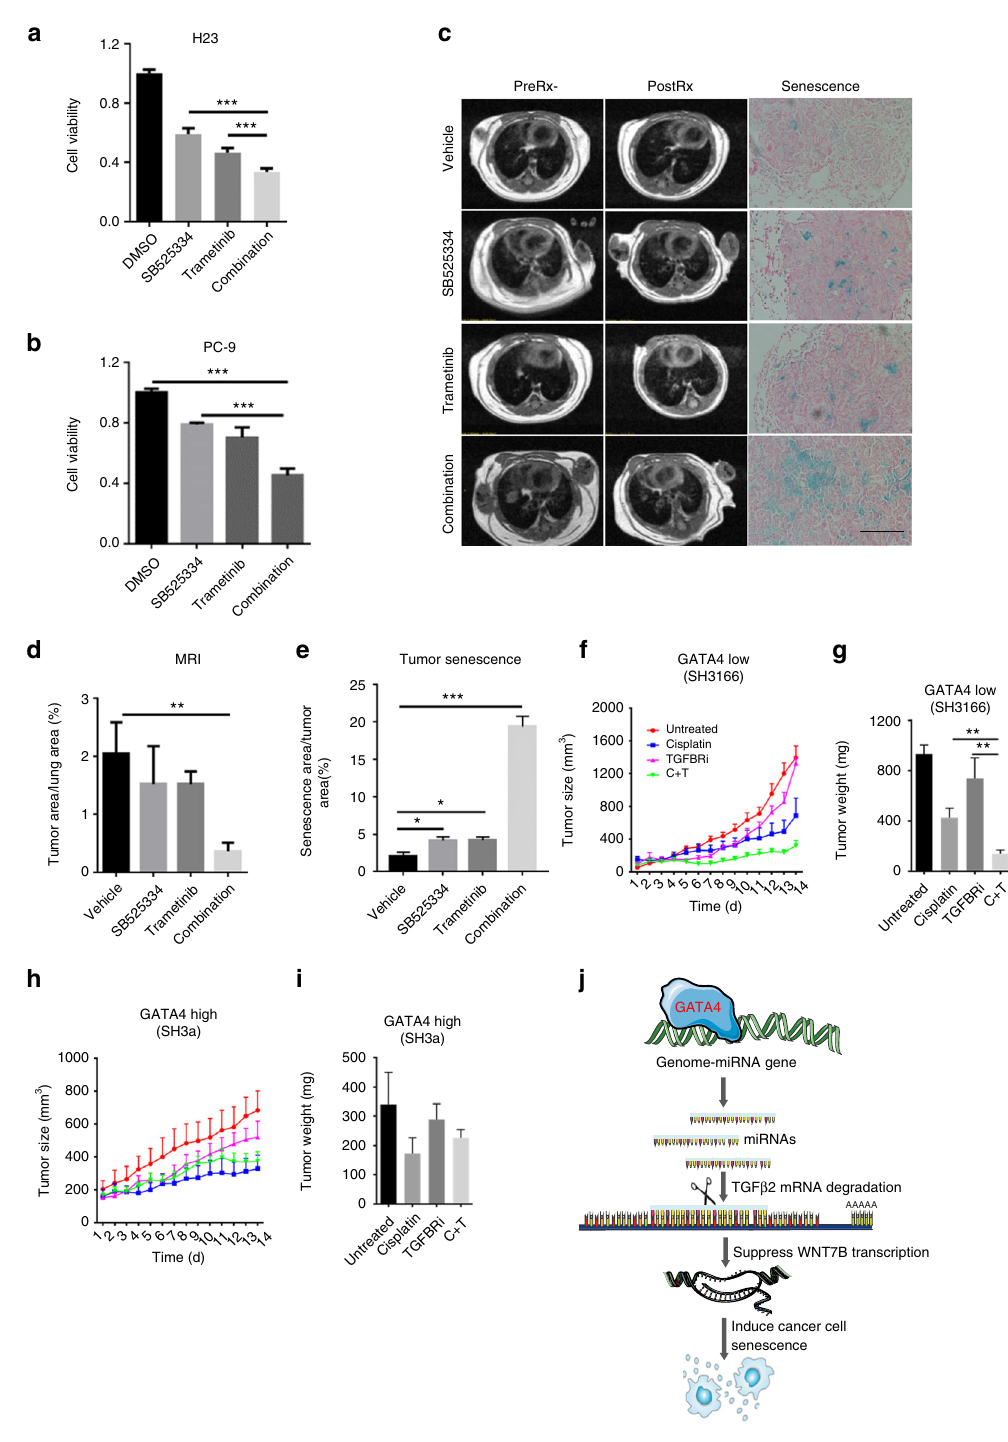
Fig. 7 TGFBR1 is a potential target for GATA4-de fi cient lung cancer. a and b 5000 cells per well seeded in 96-well plates. Cells were treated with SB525334 (2 μ M) and/or trametinib (2 μ M). CCK8 value were checked 3 days after drug treatment. a For H23 and b for PC9 ( n = 3 per group). c SB525334 (10 mg/kg/day) synergizes with trametinib (10 mg/kg/day) to shrink lung tumor in KRAS G12D /GATA4-/- mice. MRI image of lung of pre- treatment (left panel) and post-treatment (middle panel) of lung cancer bearing mice (PreRx and PostRx); β -Galactosidase staining of lung section of post- treatment mice (right panel). Scale = 100 μ m. d Statistics of lung tumor burdens recorded in MRI ( n = 4 per group). e Statistics of senescence in tumor shown ( c ) ( n = 4 per group). f , g , h and i The tumor sizes and weights of PDX tumors treated with TGFBR inhibitor (SB525334, 10 mg/kg/day), Cisplatin (5 mg/kg, once a week), or combination. SH3166: GATA4-low PDX; SH3a: GATA4-high PDX ( n = 6 per group). j Model of how GATA4 regulate TGF- β 2 and Wnt-7b signaling and cellular senescence. See text for details. Bars are represented as mean ± SEM of the indicated number ( n ) of repeats. *P < 0.05, **P < 0.01, and ***P < 0.001 by Student ’ s t